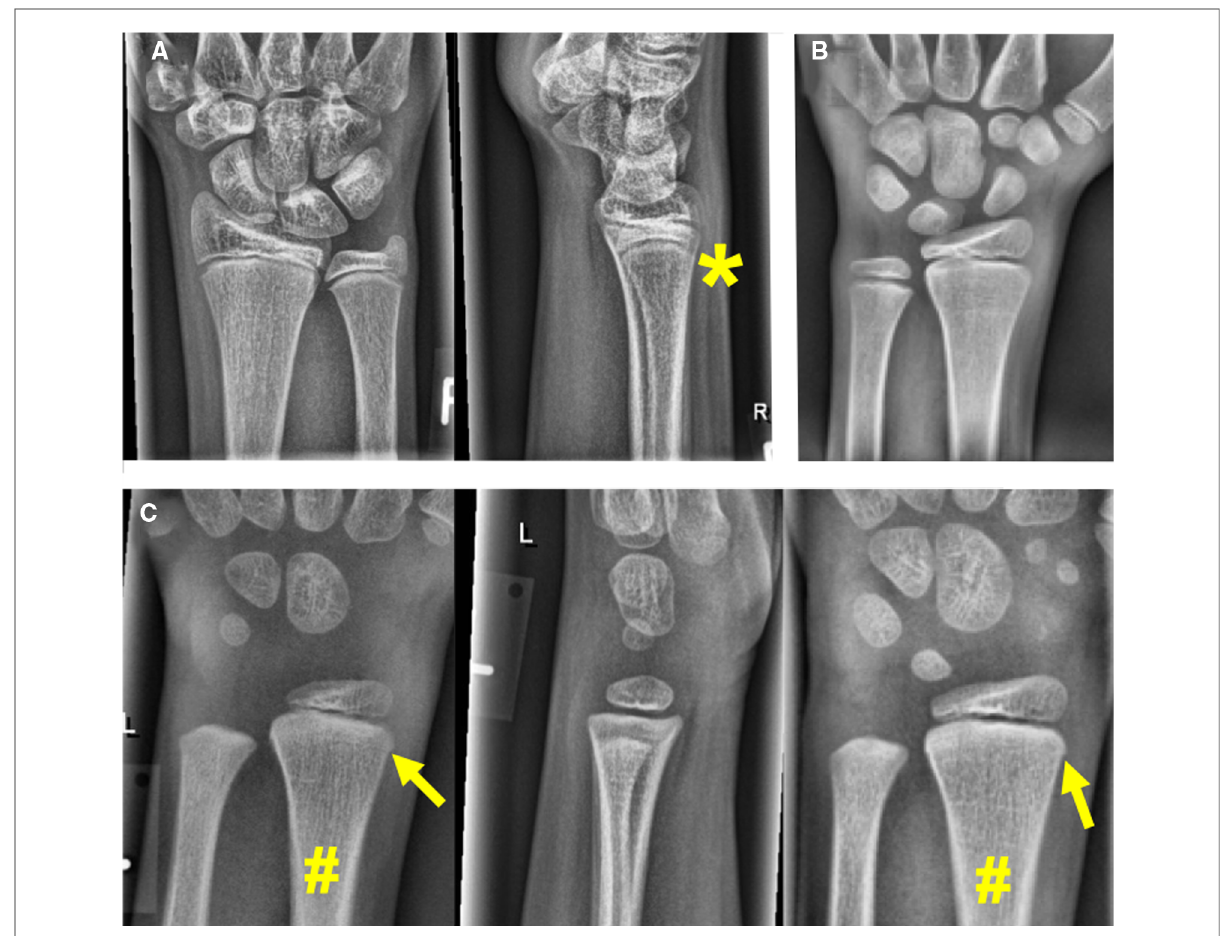
FIGURE 6 Example studies featuring the most common false positive cases. ( A ) Ef fi cientNet-B4 and ResNet-152 predicted a fracture in a case categorized as negative by the reference radiologists. There is subtlest buckling next to the asterisk (*), so a fracture cannot be ultimately ruled out. ( B ) VGG16 and 3 of 7 human experts predicted a fracture in this asymptomatic patient ’ s cropped hand x-ray (these studies do not include lateral projections). ( C ) A negative case rated positive for fracture by 3 of 7 human experts. The PA projection on the right was taken two years later. The arrows point at cortical irregularities commonly encountered in the pediatric distal radius, which are atypical for a fracture. The plus symbol (+) marks a discrete thickening of the distal radius, which is not moving away from the growth plate in the follow-up on the right. Therefore, a healed fracture is also unlikely in that